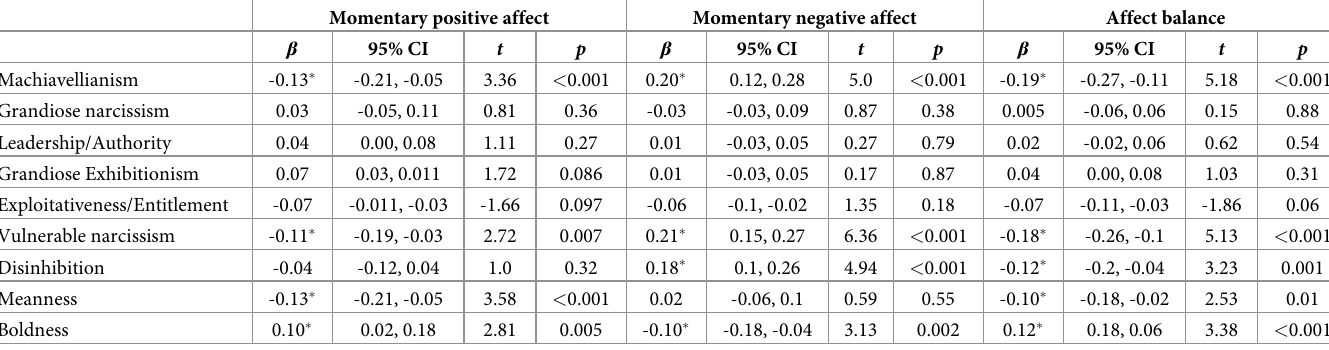
Table 2. Multilevel estimates predicting momentary affect from the Dark Triad traits. Momentary positive affect Momentary negative affect Affect